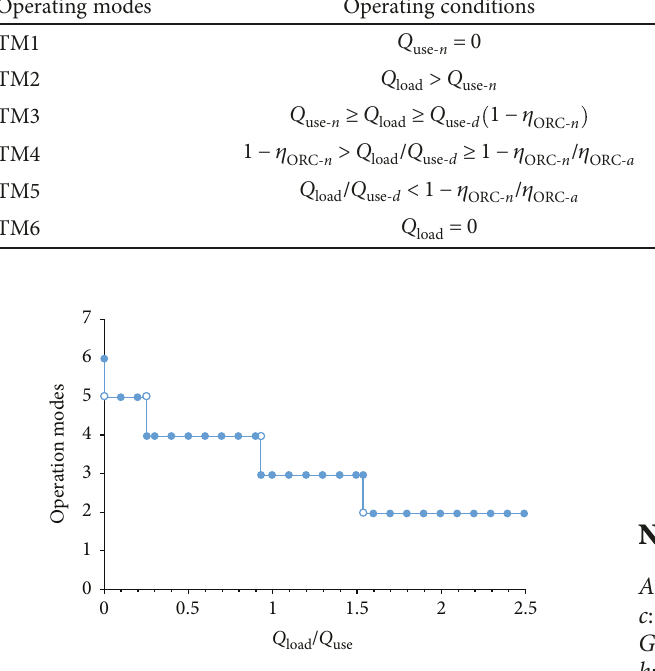
Table 5: The speci fi c state of the solenoid valves in di ff erent operating modes when the solar collectors are FPC or ETC. Operating modes